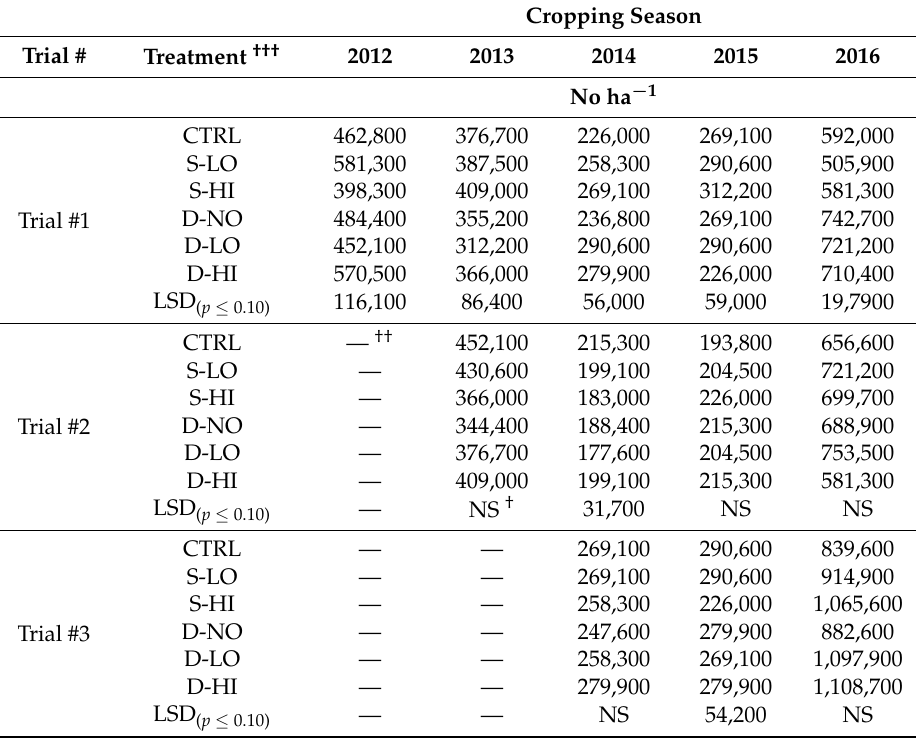
Table 5. Soybean plant populations of lime treated plots for all trials 2012 to